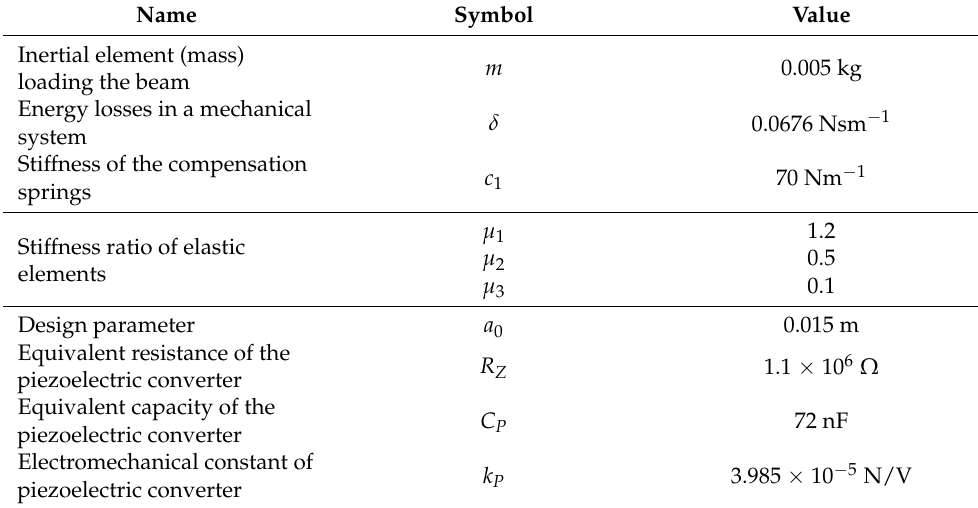
Table 1. Geometric and physical parameters of the